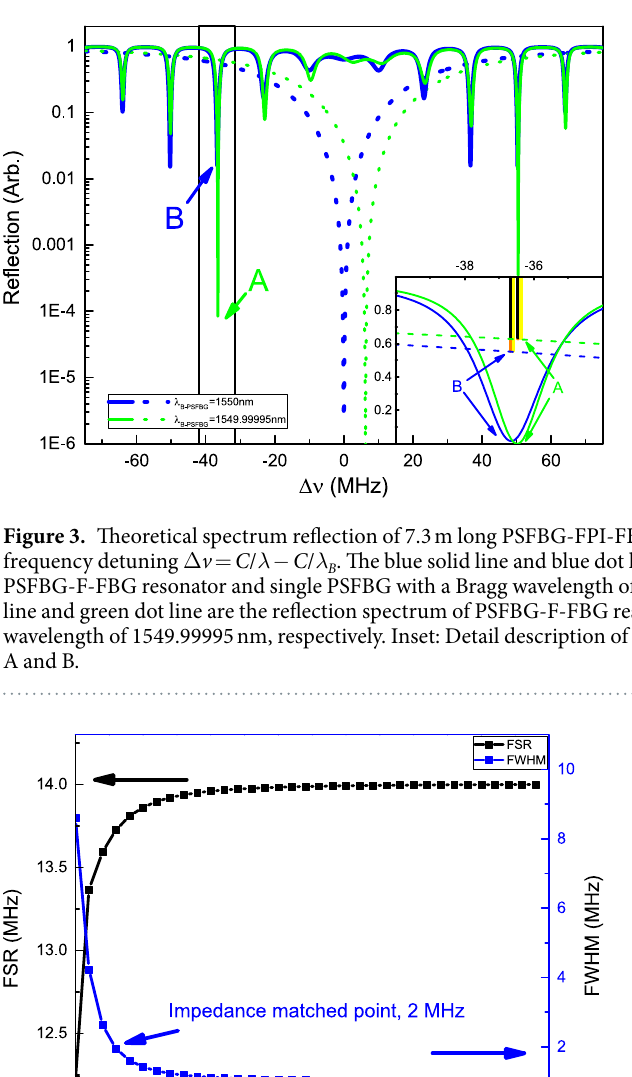
wavelength of 1550 nm is shown as the blue dot curve and the reflection spectrum of phase-shifted grating with a Bragg wavelength of 1549.99995 nm is shown as the green dot curve.) at the resonant frequency, which makes the transmission rate of phase-shifted grating equal to the fiber loss, thus realizes an impedance matched cavity mode. The tunable phase-shifted Bragg grating can be realized either by tuning the temperature of grating unit (for the grating with a Bragg wavelength of 1550 nm, about 0.004 °C temperature reduced will cause 0.05 pm blue shift of Bragg wavelength), or by supplying an extra strain to grating unit (for a grating with a Bragg wavelength of 1550 nm, about − 0.035 με strain applied will cause 0.05 pm blue shift of Bragg wavelength, since the typical normalized strain and temperature response of PSFBG are 0.78 × 10 − 6 με − 1 and 6.67 × 10 − 6 °C − 1 respectively 11 ). A refined description of impedance matching situations of point A and point B by three color vertical bars defined before is shown in the inset in Fig. 3. Linewidth of PSFBG-F-FBG resonator.